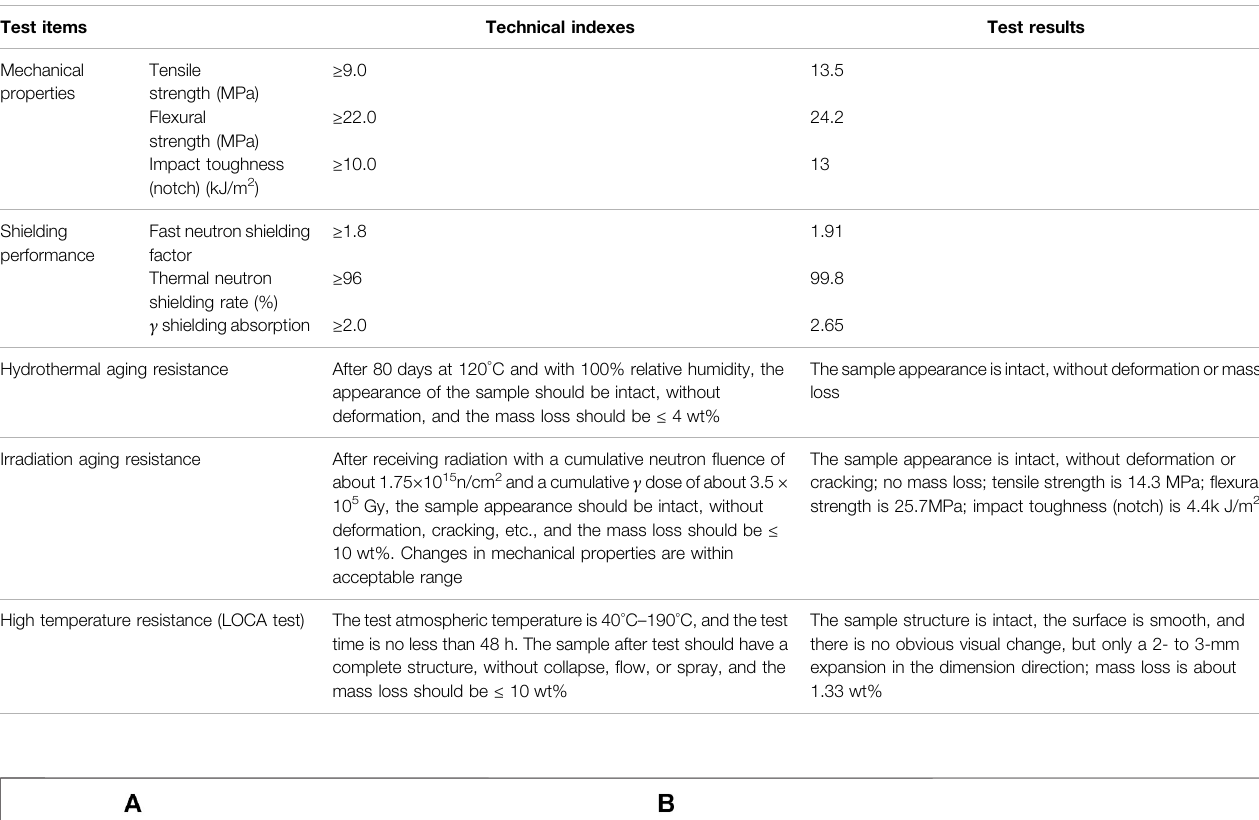
TABLE 2 | Comprehensive test results of the lead – boron polyethylene shielding composite.